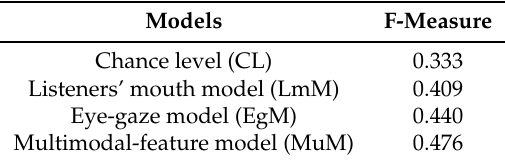
Table 2. Evaluation results of prediction models for next speaker during turn-changing. Values shown are mean of F-measures by ten-fold